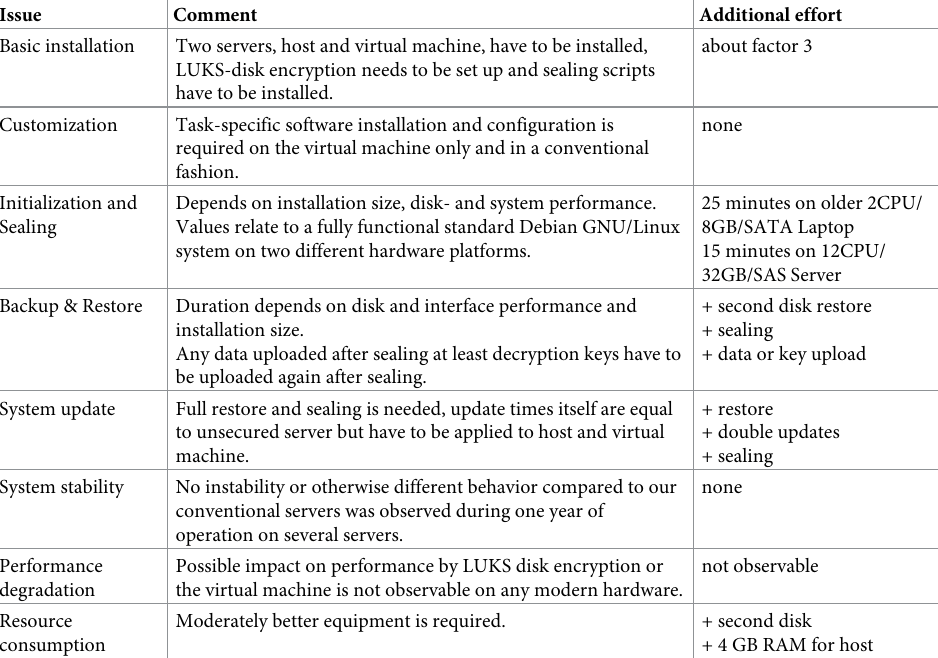
Table 2. Additional effort for data and privacy protection using a Trusted